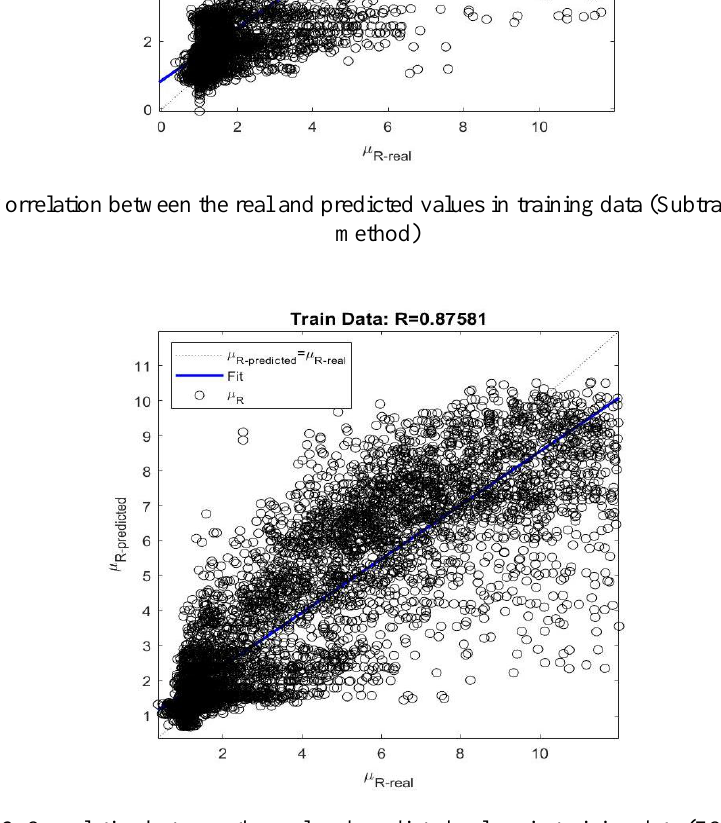
Figure 12. Correlation between the real and predicted values in training data (FCM